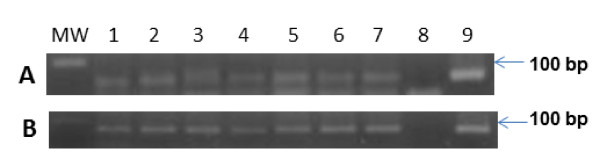
HPV-16 is detected in lung carcinomas from Asia. DNA purified from lung carcinomas from Asian patients were amplified by PCR using A: generic primers flanking the HPV L1 region (65 bp) and B: specific primers flanking the HPV-16 E6 region (96 bp) and revealed by agarose gel electrophoresis and ethidium bromide staining. MW: 100 bp molecular weight marker; wells 1-7: positive clinical samples; wells 8-9: Negative and positive control (DNA from HPV-16 recombinant plasmid).